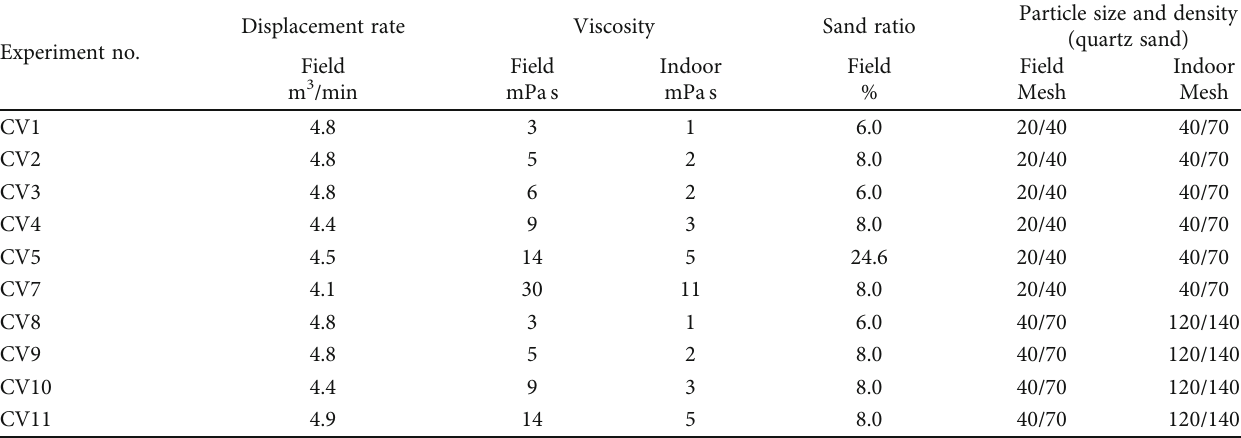
Table 5: Fracturing fl uid viscosity exploration experimental scheme of LD C7.